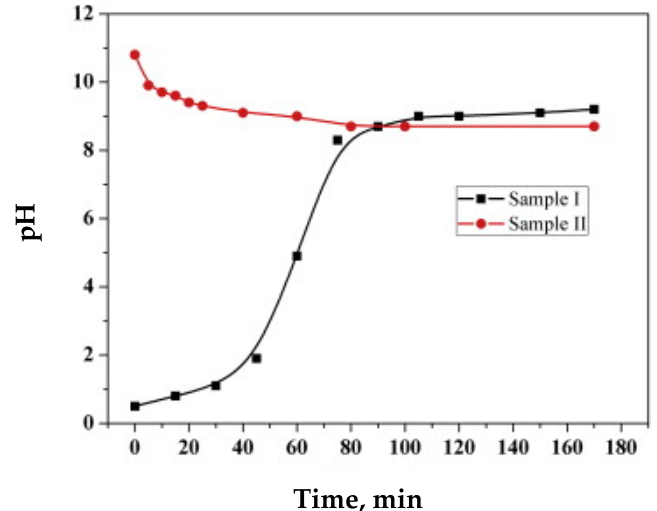
Figure 6. Variation of pH in the reaction medium during coprecipitation. Reproduced with permission from [31], published by Elsevier B.V., 2015.